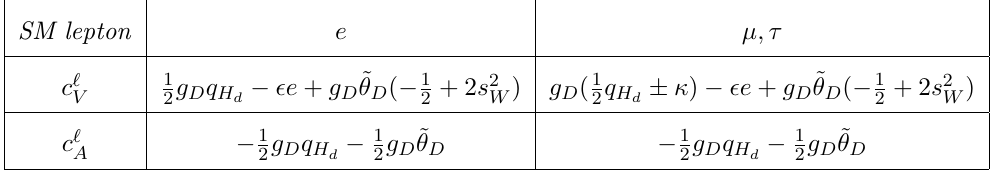
Table 2 . Axial and vector couplings for SM charged leptons in a 2HDM scenario. In the top-right entry, the plus sign applies to c (cid:22) mass